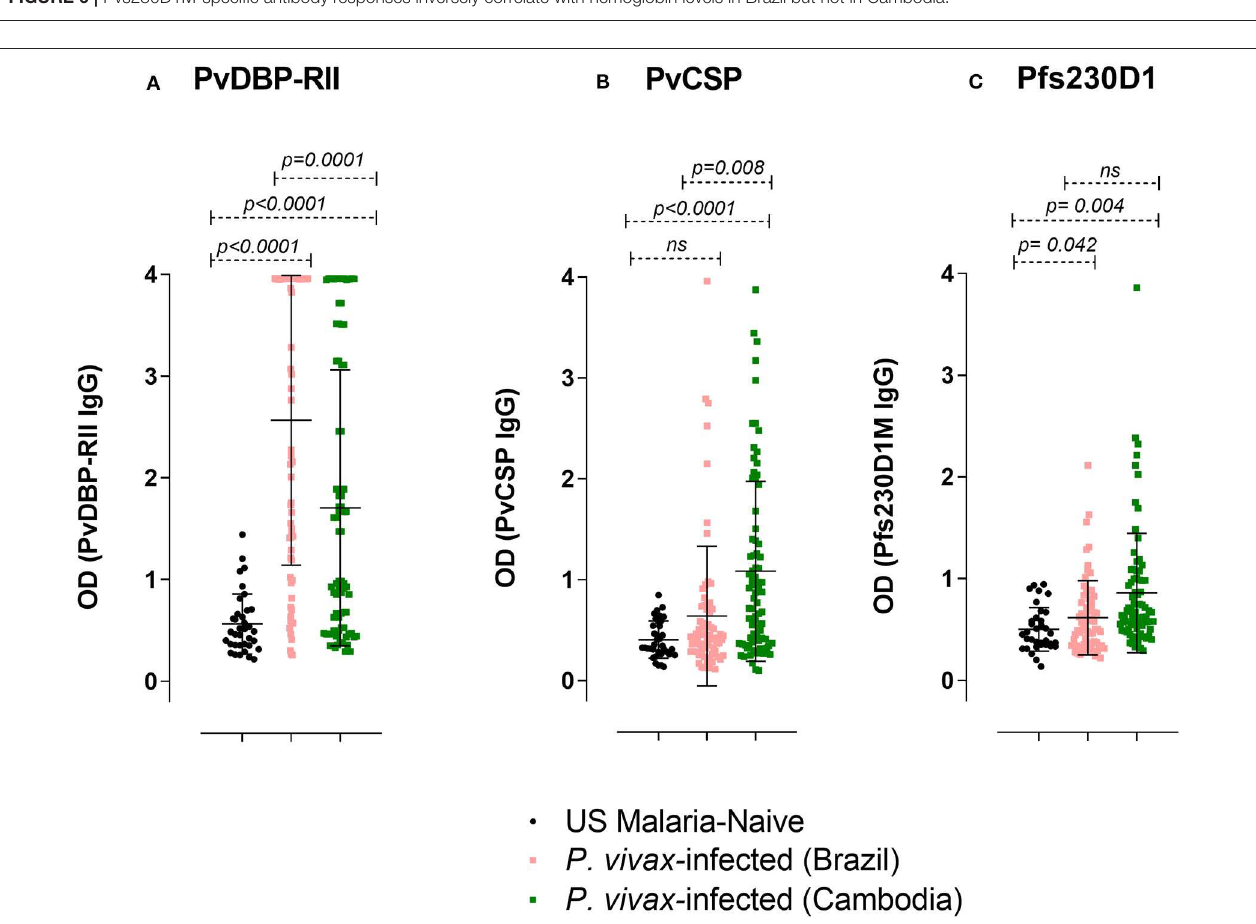
FIGURE 7 | IgG ELISA levels against PvDBP-RII, PvCSP, and Pfs230D1M in P. vivax- infected subjects. The seroprevalence of IgG antibodies with specificity for (A) PvDBP-RII in Brazil was 67.1% (47/70 subjects) and in Cambodia 48.1% (38/79 subjects); (B) PvCSP in Brazil was 11.4% (8/70 subjects) and in Cambodia 41.8% (33/79 subjects); (C) Pfs230D1M in Brazil was 7.2% (5/69 subjects; the volume of one sample was insufficient for assay) and in Cambodia 16.5% (13/79). The cut-off levels for detection (1.44, 0.97, and 1.16 respectively for PvDBP-RII, PvCSP, and Pfs230D1M ELISA) were based on control mean + 3SD calculation. One-Way ANOVA followed by multiple comparisons was used for this analysis and results are displayed as mean ± SD.